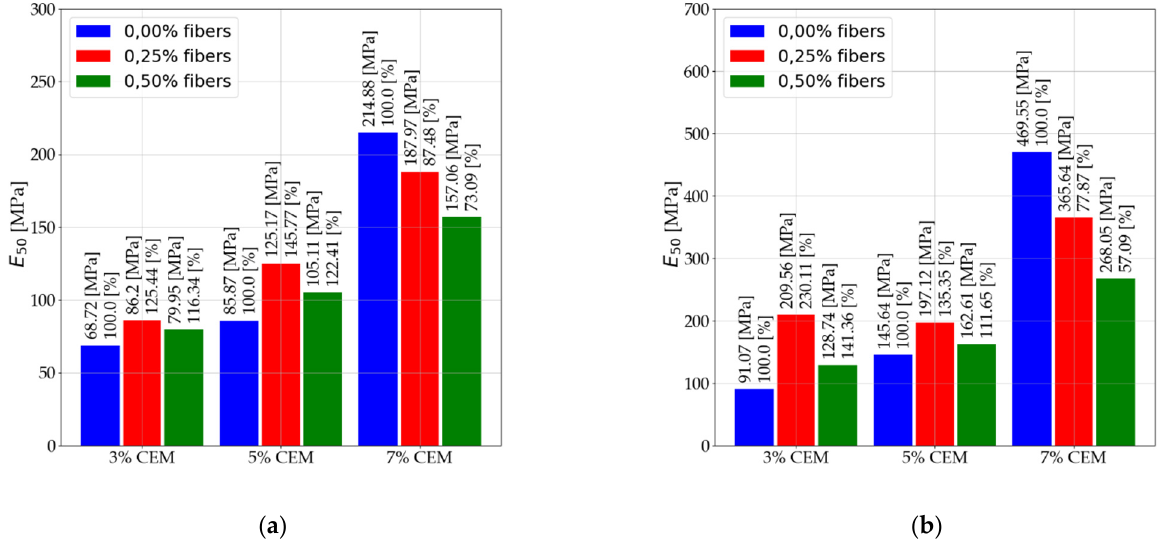
Figure 8. Values of secant modulus E (cid:2873)(cid:2868) after 7 days of care ( a ) before interpretation and ( b ) after interpretation.